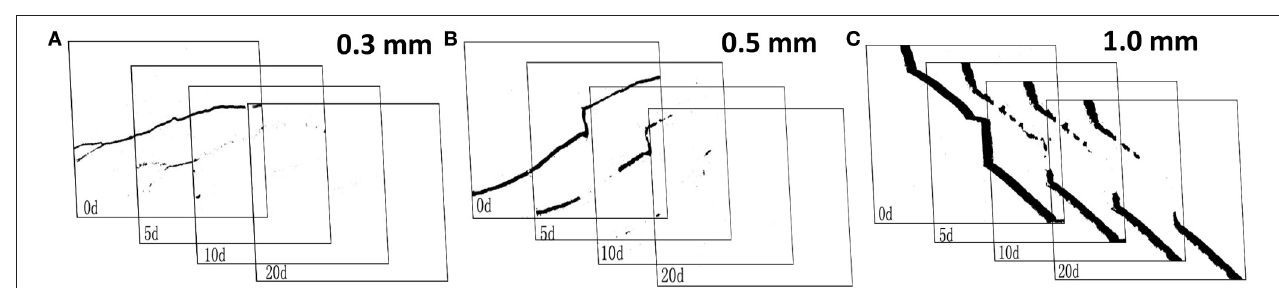
FIGURE 9 | The binary images of different width crack after different healing